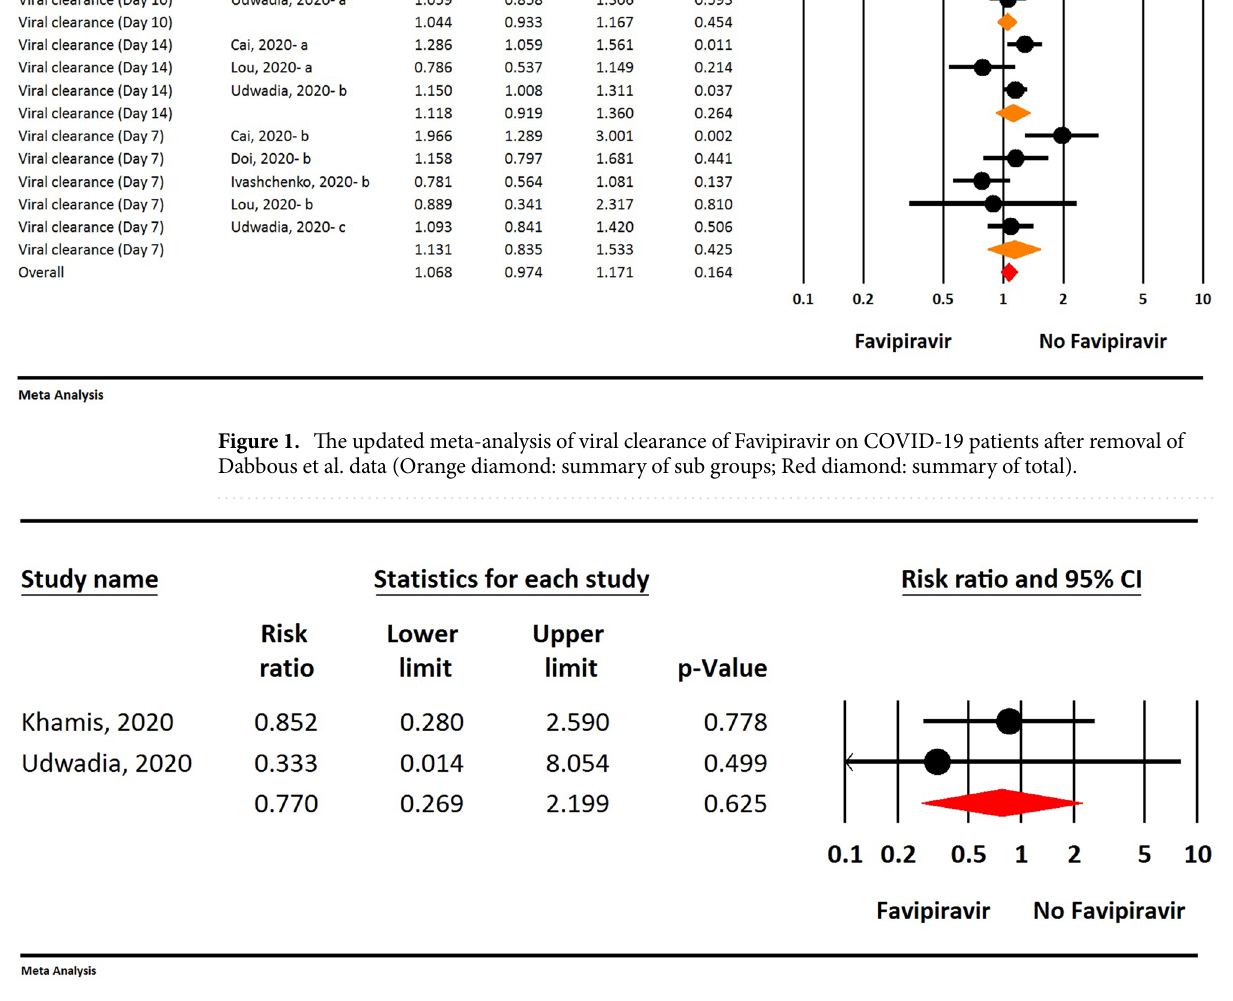
Figure 2. The updated meta-analysis of mortality of Favipiravir on COVID-19 patients after removal of Dabbous et al. data (Red diamond: summary of